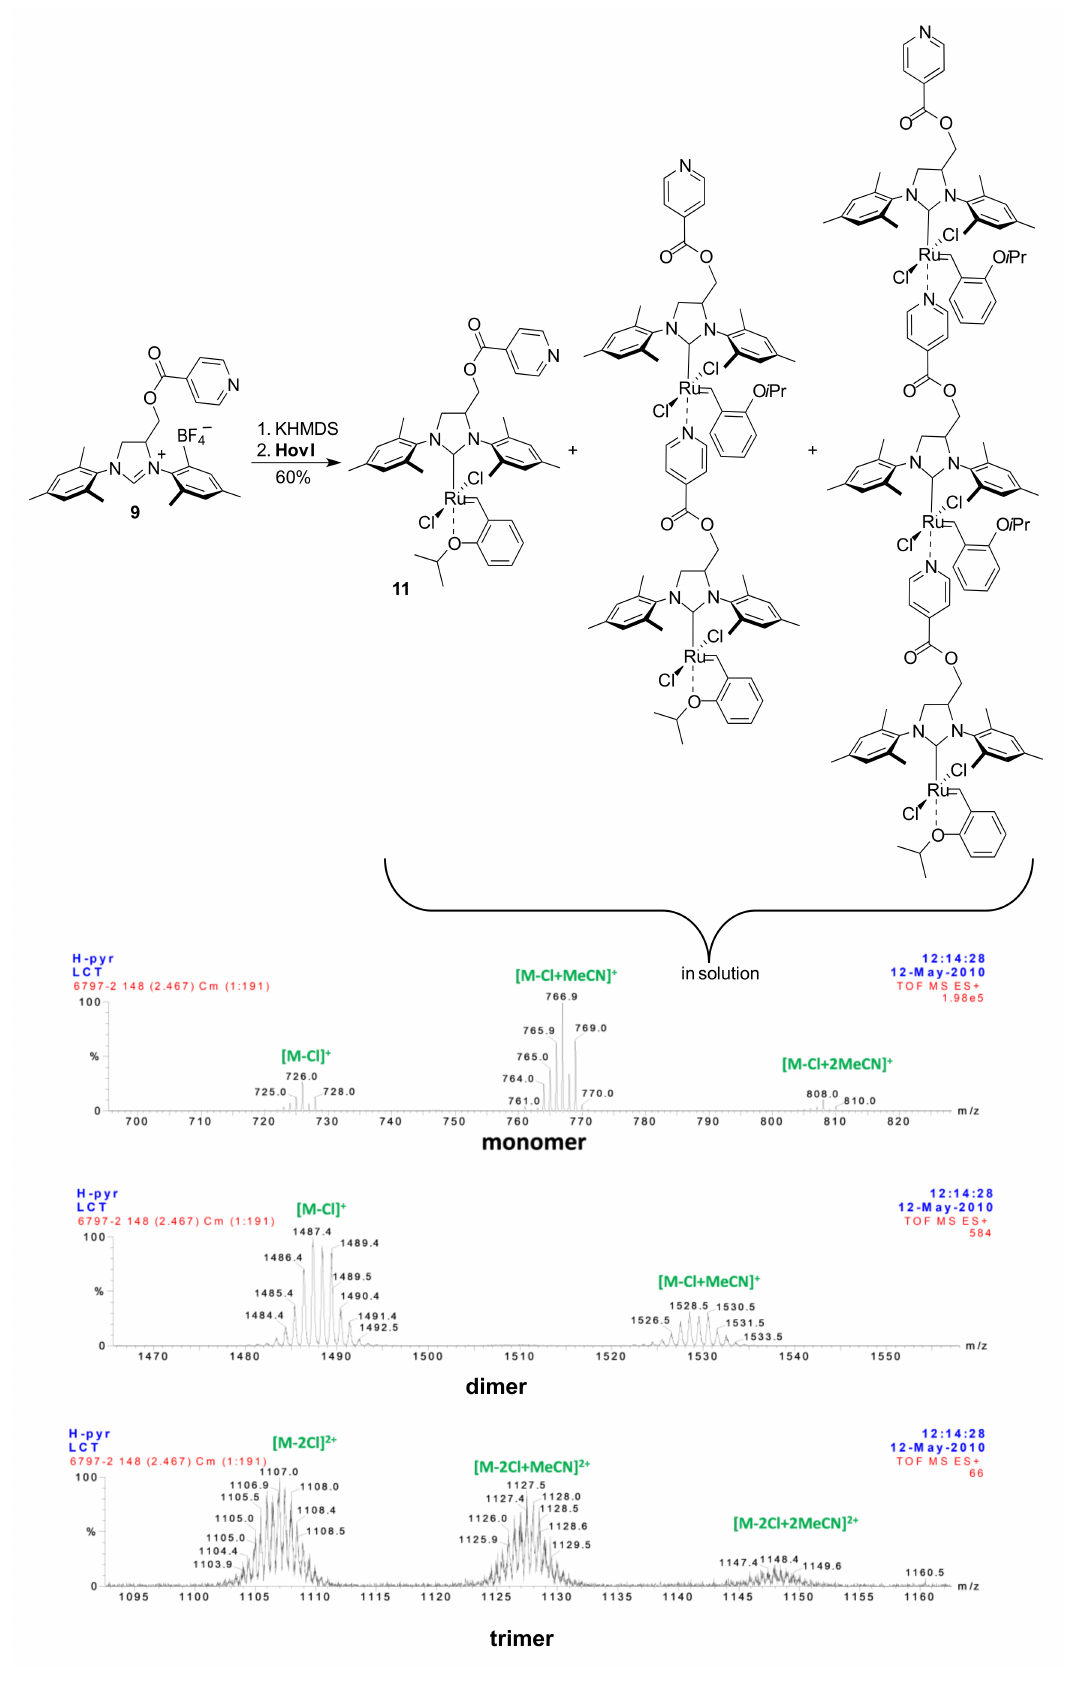
Scheme 5. Formation of dimers and trimers of complex 11 and their MS ESI